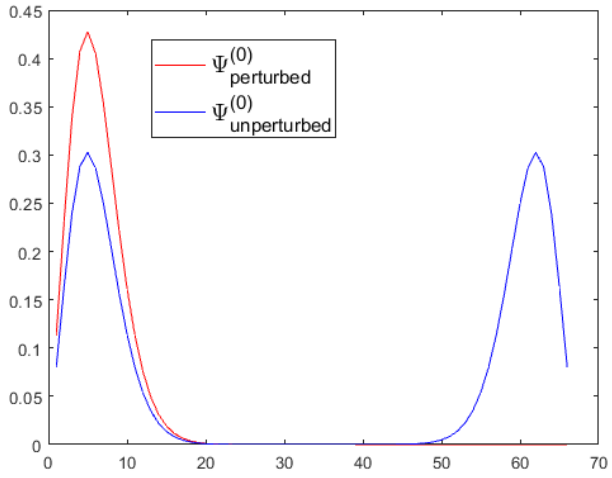
Figure 10: Corresponding ground state (in red) of the perturbed Hamiltonian + ∆ V h CW is already localized for N = 65 , b = ( N − 9 ) / N, c = 1 / 45 , d = 0.4 , N N J = 1 and B = 1 / 2 . Localization takes place on the left side of the well, since the flea raises the potential on the right